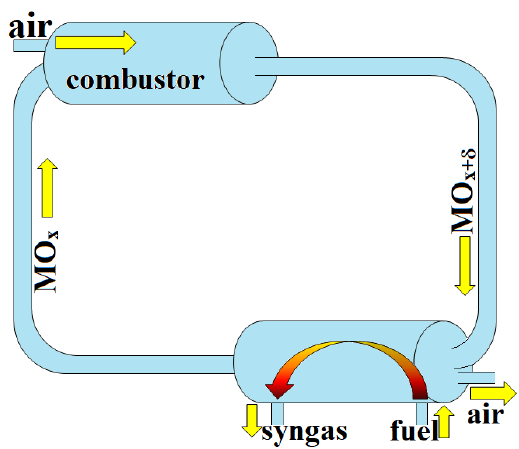
Figure 5. Scheme of hydrogen production with the use of chemical looping combustion.